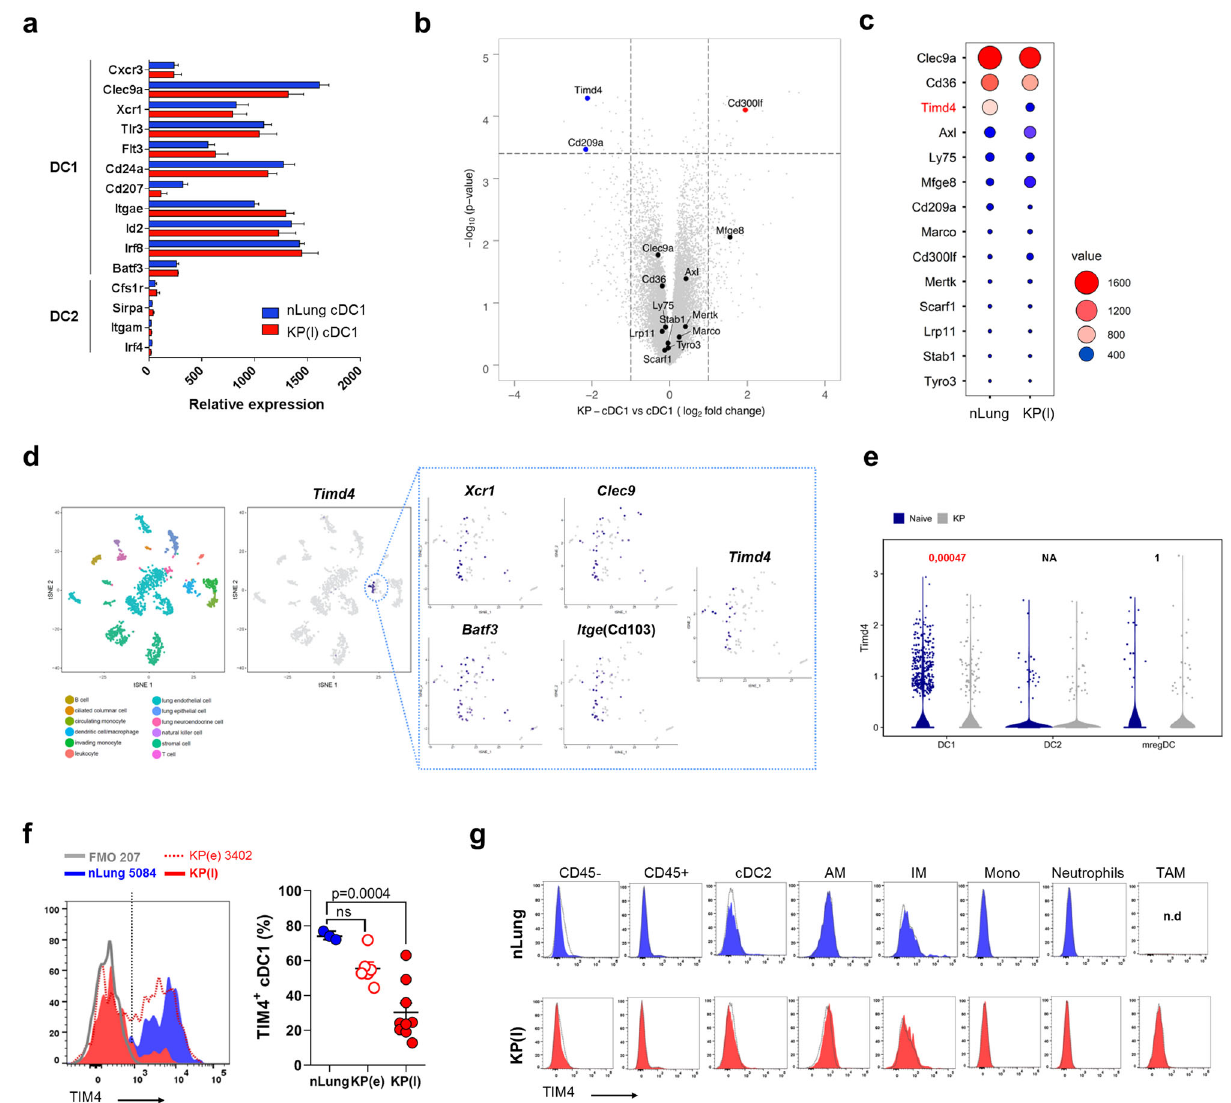
Fig. 3 Selective cDC1 expression of the PtdSer receptor TIM4 in lung phagocytes and downregulation in tumors. a cDC1 were isolated from nLung or late KP tumors to analyze transcriptional pro fi les. The graph shows expression of cDC1 and cDC2 lineage speci fi c genes in nLung-sorted and tumor-sorted cDC1. Data are expressed as mean ± SD with nLung n = 4, KP(l) n = 3. b Volcano plot showing the fold change of genes encoding scavenger receptors (signi fi cantly modulated genes are depicted in red and blue, using a q -value < 5%, a false discovery rate (FDR) ≤ 5% and a fold change ≥ 2 or ≤ 2), using the Signi fi cance Analysis of Microarray (SAM) algorithm. c The dot-plot shows the relative abundance of genes in b using a color and size scale of linear expression values. d T-distributed stochastic neighbor embedding (tSNE) plots of single cells expression pro fi les in mouse lungs (Tabula Muris). Colors represent clusters of different subsets based on global similarity of gene expression. The cluster corresponding to DC-macrophages was further analyzed to assess co-expression of cDC1 markers and Timd4 transcripts, as depicted in the boxes. e scRNA seq of naive and KP lung tumors from 16 were analyzed to visualize Timd4 -expressing cells in three subpopulation of lung DCs. Violin plots show expression of Timd4 in cDC1, cDC2, and mregDCs. Statistical analysis was performed using Seurat R package, taking in consideration both number of expressing cells and levels of expression. f Representative histograms and quanti fi cation of the percentage of cells expressing TIM4 in nLung, early and late lung tumors (the gate for identi fi cation of positive and negative cells is depicted in the histogram). Data are from nLung n = 3, KP(e) n = 6, KP(l) n = 9 mice. Signi fi cance was determined by one-way ANOVA followed by Tukey ’ s post-test; data are expressed as mean ± SEM. g Representative histograms of TIM4 expression on total CD45 − and CD45 + cells and all lung phagocytic subsets in nLung and late KP lungs. Alveolar macrophages (AM), interstitial macrophages (IM), tumor associated macrophages (TAM), monocytes (Mono). Each peak is overlaid on the corresponding FMO controls (black line). Source data are provided as a Source Data fi fl uorescent only under acidic conditions 39,40 (Fig. 4c). Blockade of TIM4 blockade on phagocytosis of dying thymocytes. TIM4 blocking antibodies in nLung selectively reduced the uptake by or genetic deletion of TIM4 impacted similarly on the subsequent cDC1 almost to the level found in KP tumors, and had no step of antigen presentation. Blocking antibodies decreased additive effect when administered to tumor lungs (Fig. 4b) antigen presentation of KP-OVA antigens (peptide:MHC OVA (Supplementary Fig. 7g). Uptake was reduced as well in cDC1 complexes labeling) by tissue cDC1 (Fig. 4d), and proliferation of isolated from wt or Timd4 − / − mice and incubated with apoptotic adoptively transferred CD8 T cells into mice receiving OVA thymocytes labeled with pH Rodo, a probe that becomes loaded apoptotic thymocytes (Fig. 4e). Finally, cDC1 isolated